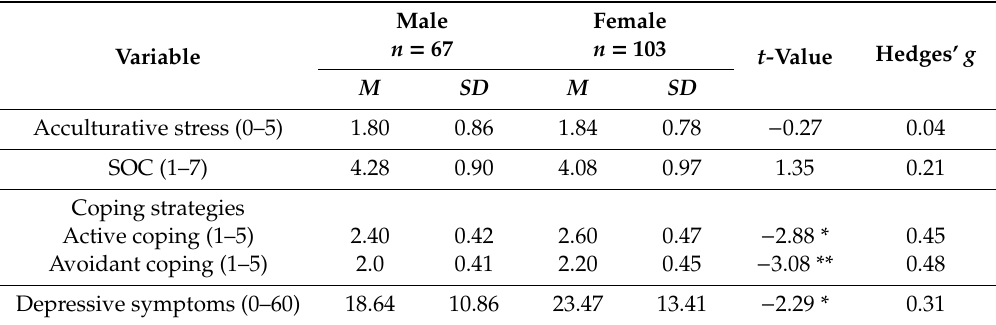
Gender differences in acculturative stress, SOC, active coping, avoidant coping, and depressive symptoms.